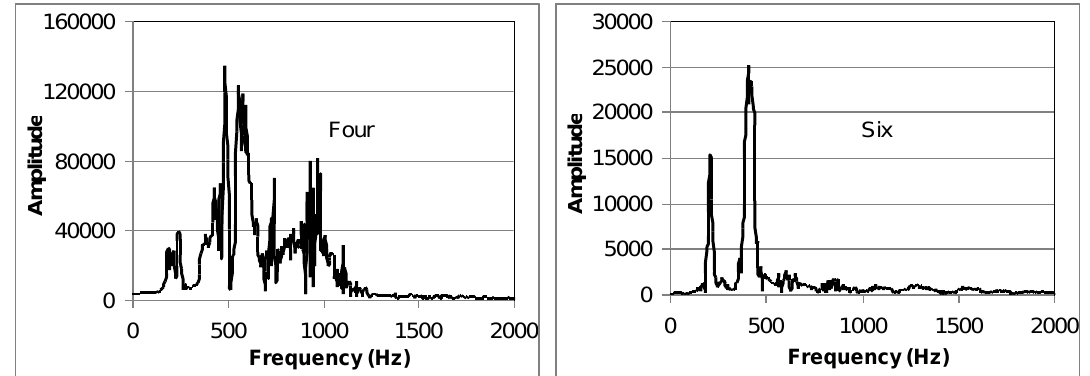
Fig. 7: Two amplitude frequency spectra for voice of female with age of 30 year while pronouncing the two words ‘Four’ and